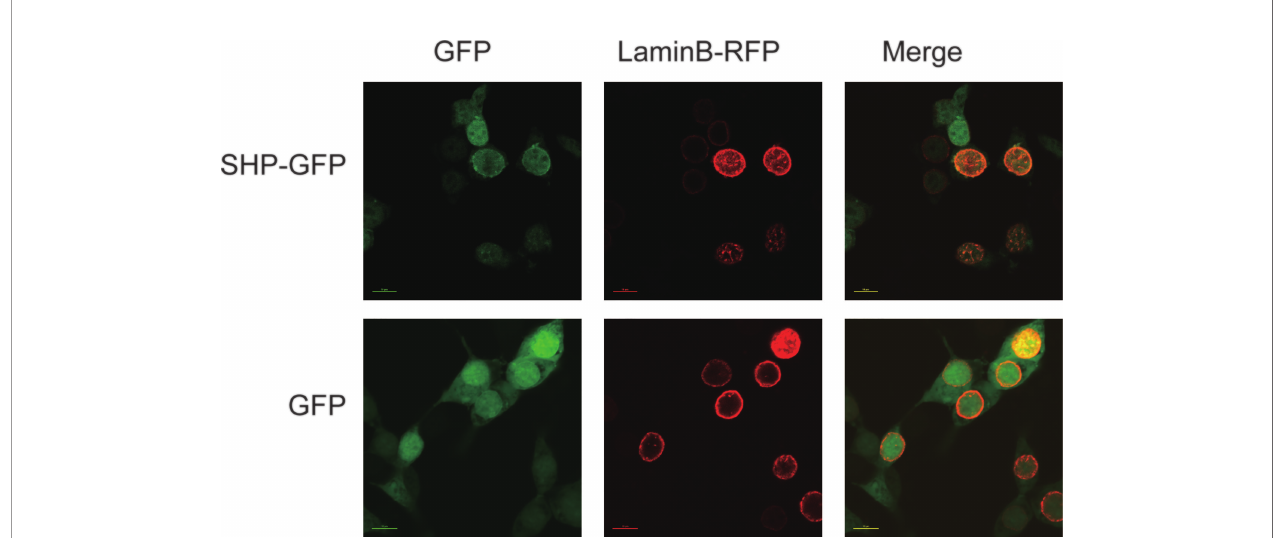
FIGURE 5 | Localization of large yellow croaker SHP in HEK 293T cells. GFP, Green fl uorescent protein; SHP-GFP, small heterodimer partner and GFP fusion proteins; Lamin B-RFP, Lamin B and red fl uorescent protein fusion proteins.